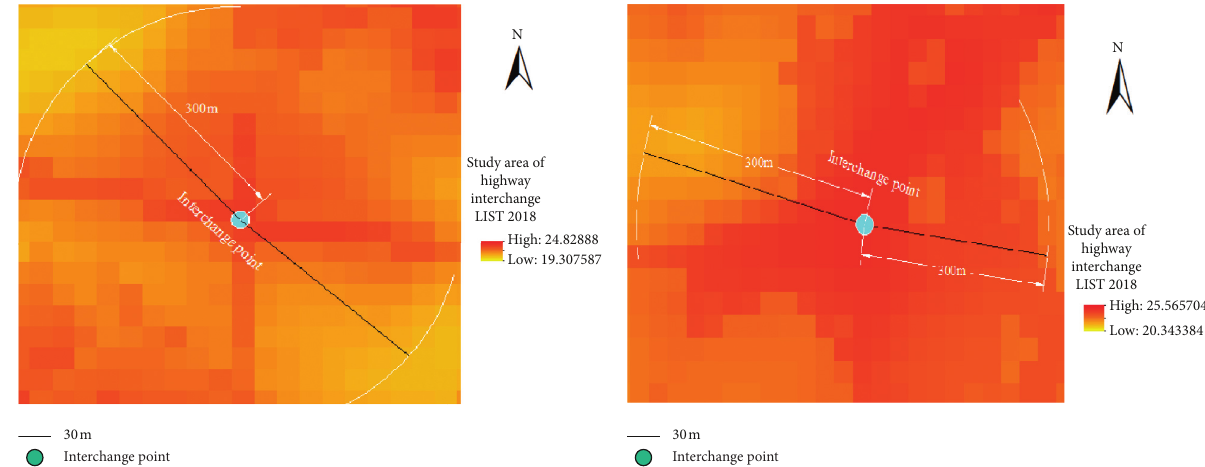
Figure 12: Temperature spread diagram of a typical interchange intersection in a highway.